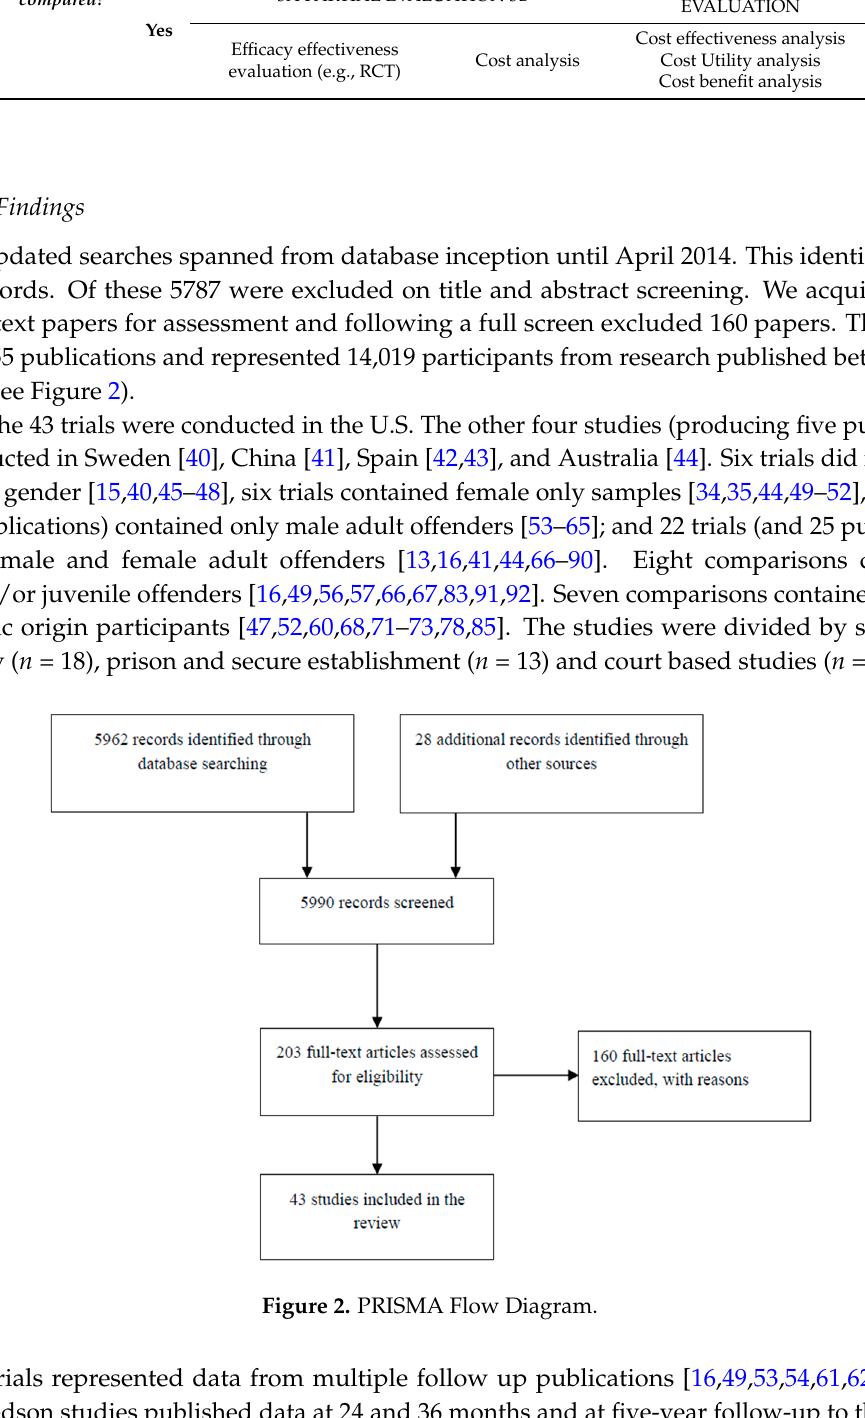
Table 1. Classification scheme for economic evaluations (Drummond 2005).